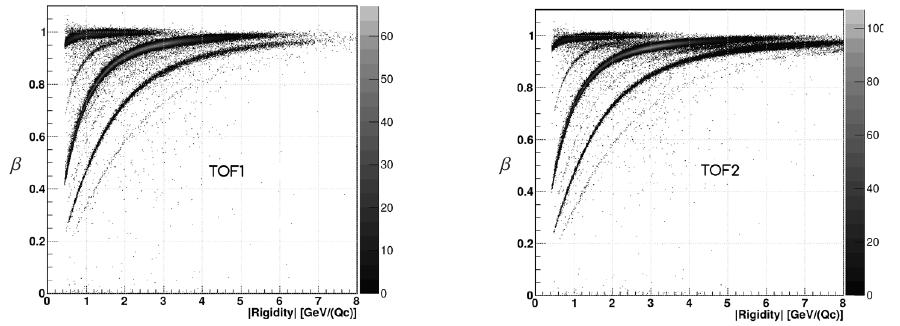
Figure 5. Dependency of particle velocity ( β = v/ c ) on particle